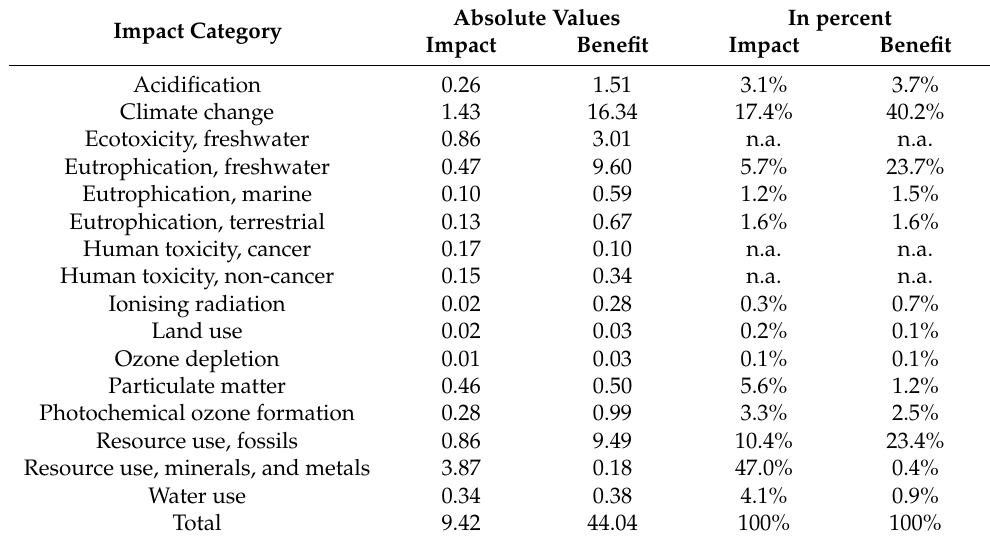
Table 5. Single score results of the change of 1 ha single-use agriculture to an AVS in Germany per year (n.a.: not